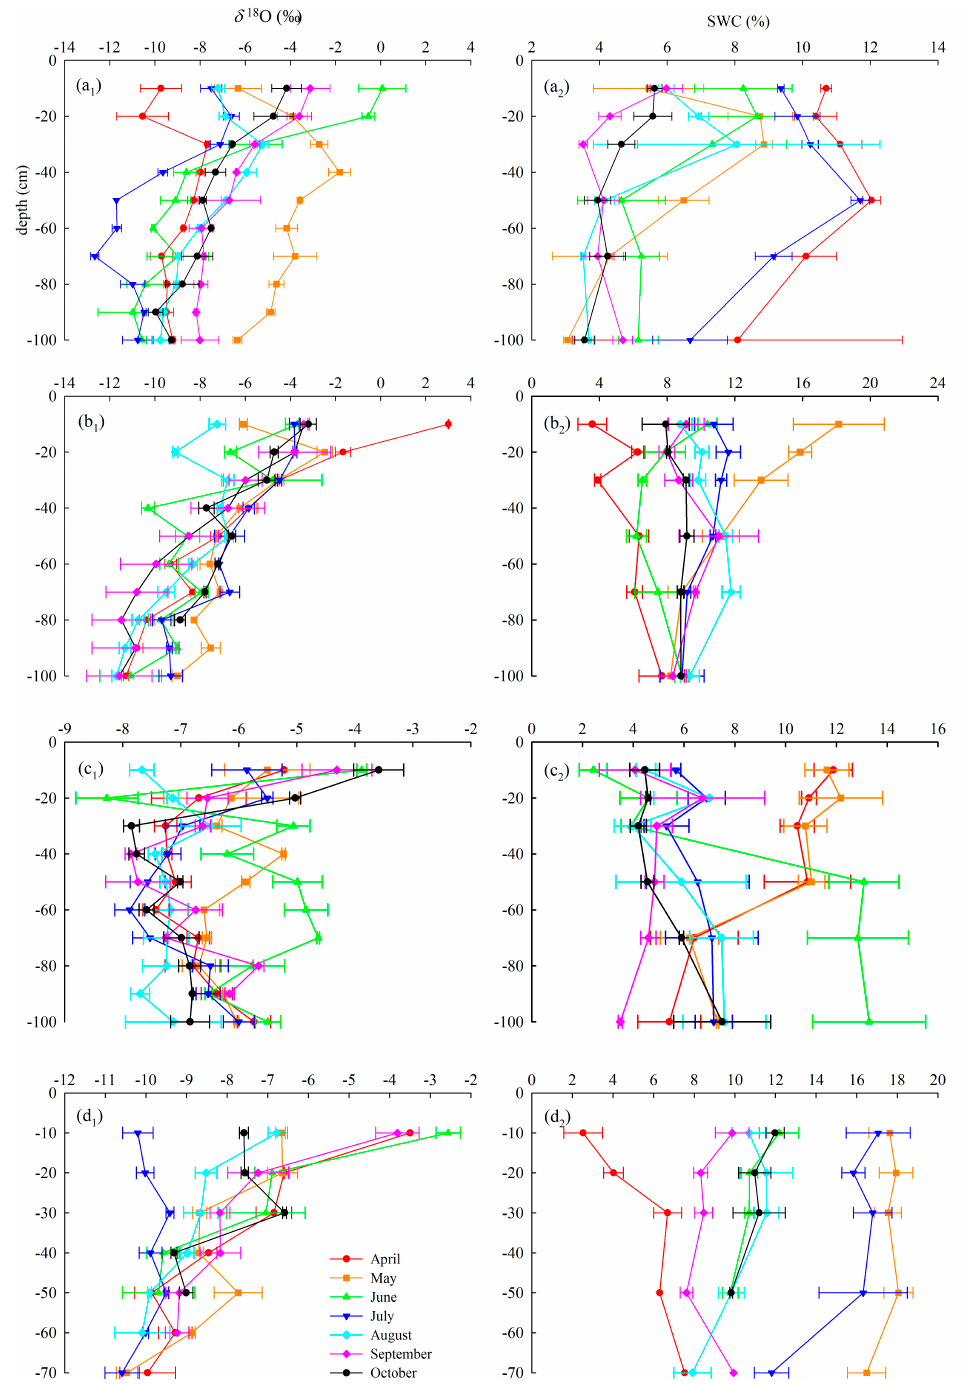
Figure 4. Monthly variation of soil water δ 18 O and SWC in Lanzhou (( a – d ) represent Jiuzhoutai, Northwest Normal University, Beishan and Wetland Park, 1 and 2 represent soil water δ 18 O and SWC, respectively, and the horizontal crossbar represents standard deviation, n = 3).